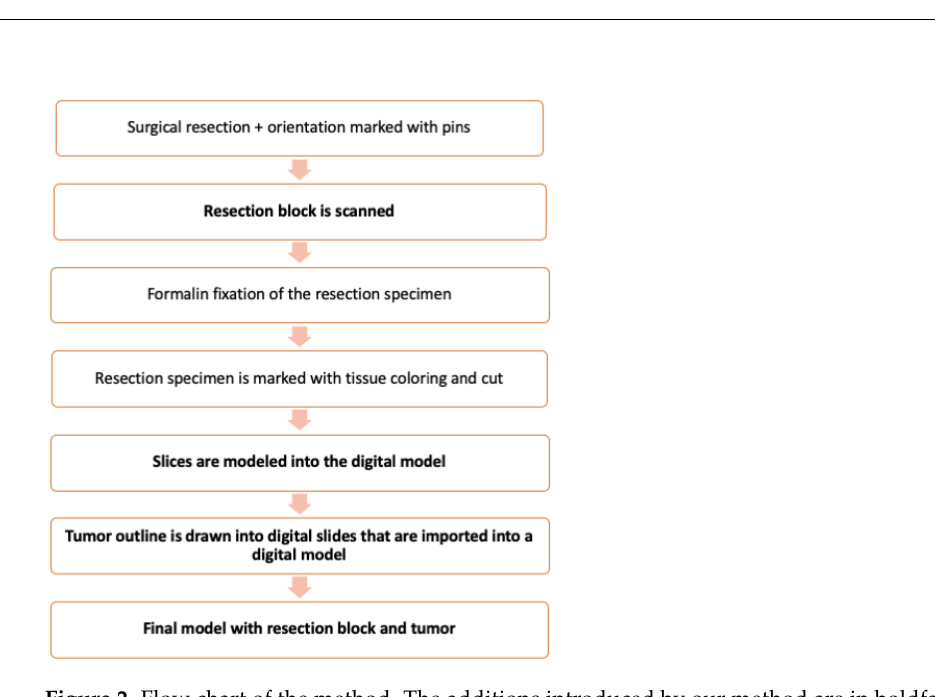
Figure 2. Flow chart of the method. The additions introduced by our method are in boldface.